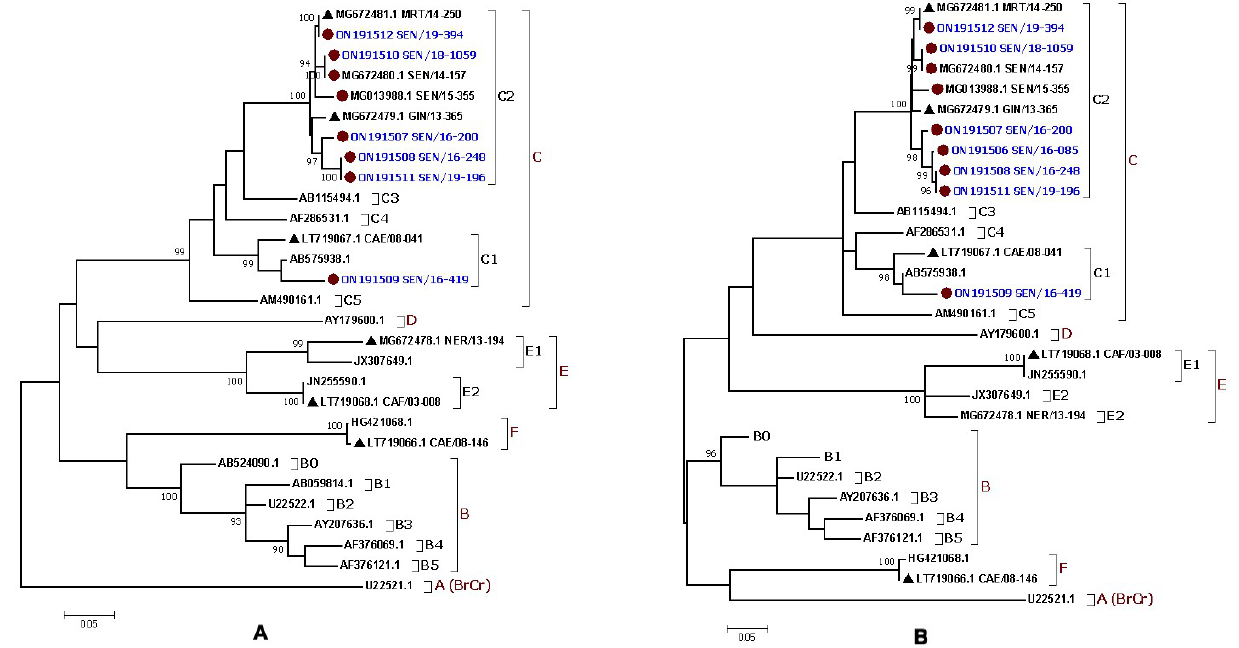
Figure 2. Maximum likelihood (ML) phylogenetic trees based on ( A ) eight complete polyprotein sequences (~7400 bp) and ( B ) nine partial VP1 sequences (~775 bp) from the EV-A71 isolates identified in Senegal. The newly characterized sequences are highlighted in blue. Bootstrap values ≥ 90 are shown on the tree. The small red circle and the small black triangle indicate the strains from Senegal and the other African countries, respectively. The scale bar indicates the distances of the branches. The tree shows that all the Senegalese EV-A71 strains belonged to the genogroup